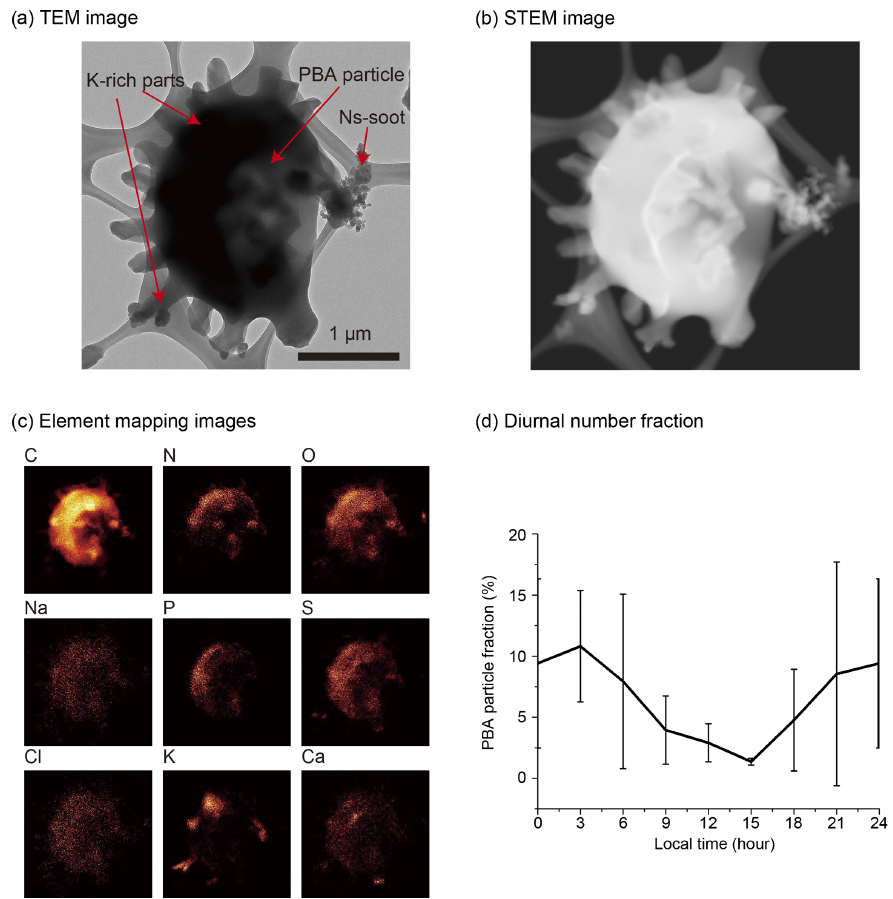
Figure 8. Shape, compositions, and diurnal abundance of PBA particles. (a) TEM, (b) STEM, and (c) element mapping images of a PBA particle. This particle contains K-rich and C-N-O-rich grains and attaches an ns-soot particle. The sample was collected from 00:00 to 00:30 on 27 February 2014. (d) Diurnal number fractions of PBA particles. The fractions were averaged values for all samples. Error bars indicate the 95% confidence